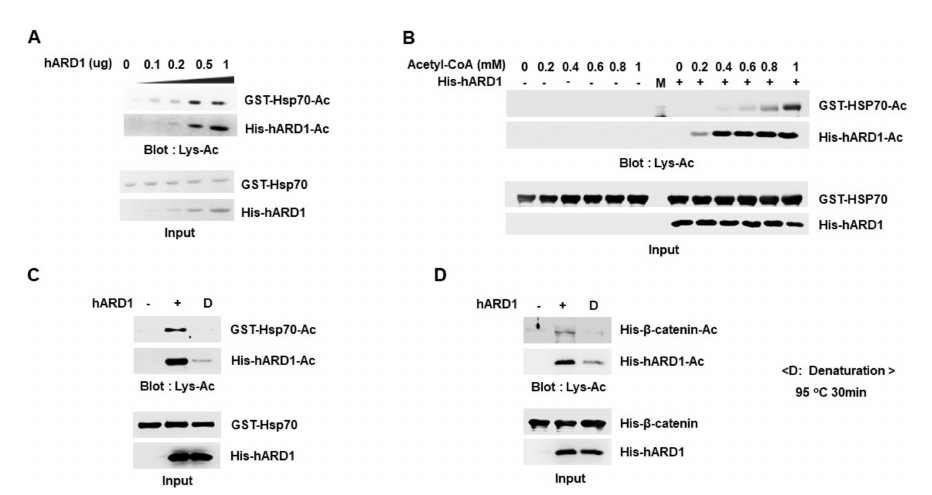
Figure 4. hARD1 / NAA10-mediated enzymatic lysine acetylation is dependent on concentration of reactants. ( A ) Acetylation of Hsp70 occurs in a hARD1 / NAA10 dose-dependent manner. Hsp70 recombinantproteinwasappliedtoin vitroacetylationassayinthepresenceofincreasingconcentrations of rhARD1 / NAA10 protein for 1 h at 37 ◦ C. ( B ) Acetylation reaction mediated by hARD1 / NAA10 is influenced by the concentration of acetyl-CoA. Hsp70 recombinant protein was incubated with or without hARD1 / NAA10 in the presence of increasing concentrations of acetyl-CoA for 1 h at 37 ◦ C. M, protein marker. ( C ) KAT activity of hARD1 / NAA10 is lost under harsh denaturation conditions. rhARD1 / NAA10 protein was denatured at 95 ◦ C for 30 min prior to its incubation for in vitro acetylation assay in the presence of Hsp70 recombinant protein for 2 h at 37 ◦ C. Western blot analysis was carried out to evaluate the acetylation status of proteins. ( D ) rhARD1 / NAA10 was heated at 95 ◦ C for 30 min prior to being subjected to in vitro acetylation assay in the presence of β -catenin. Acetylation levels were measured by western blot